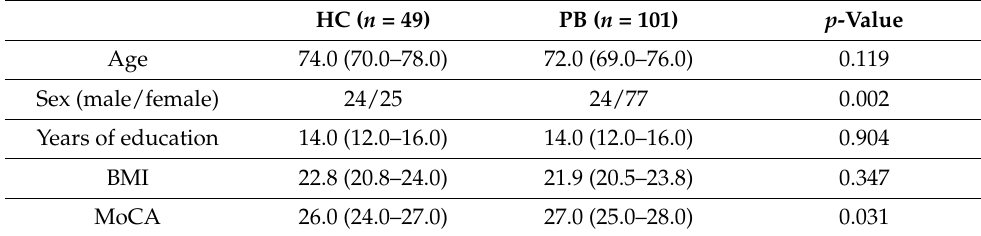
Table 1. Characteristics of Cohort A classified by cluster